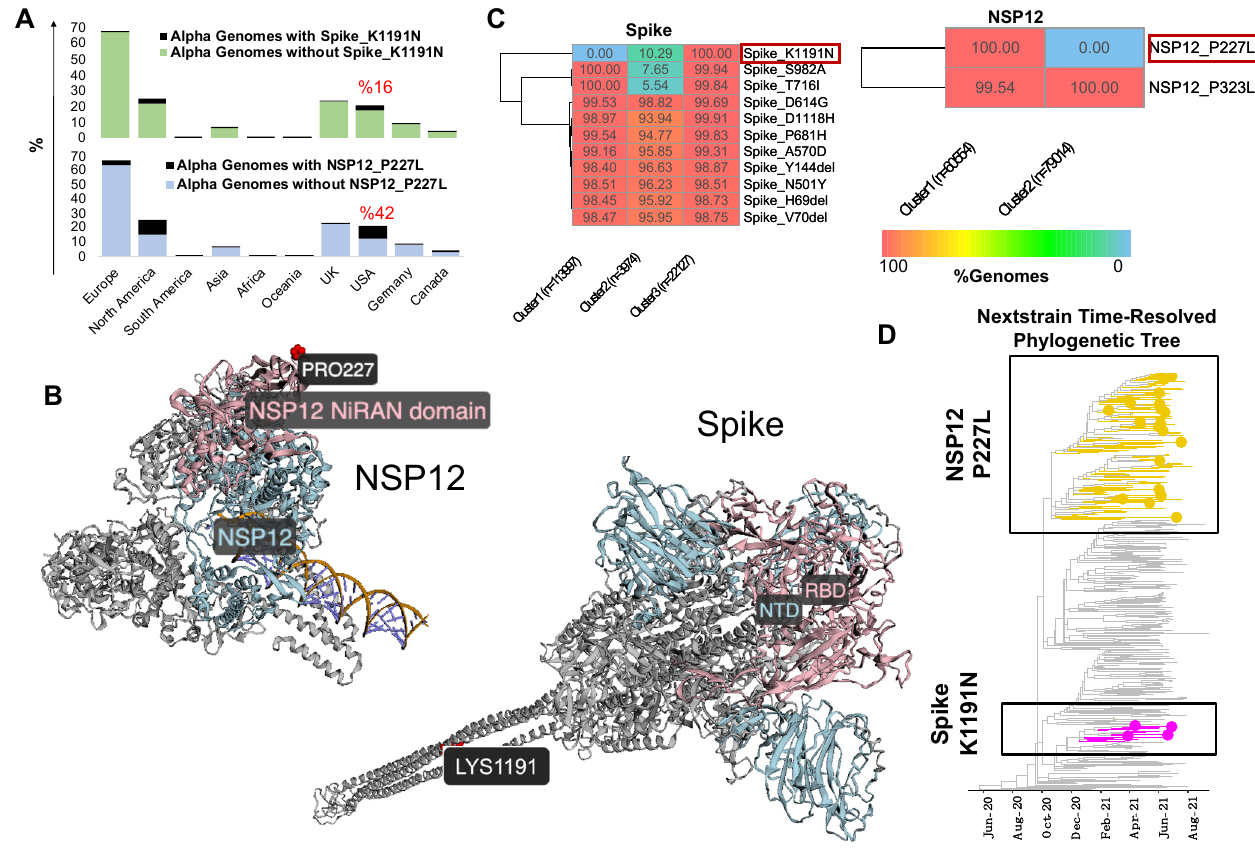
Figure 5. Analysis of Alpha VOC mutations predominantly found in USA specimens. ( A ) Relative frequency of Alpha VOC SARS-CoV-2 genomes harboring Spike K1191N ( top ) or NSP12 P227L ( bottom ) mutations. Calculations are based on GISAID data as of 31 May 2022. ( B ) Spike K1191N ( top ) or NSP12 P227L ( bottom ) mutations highlighted on available protein structures using the ViralVar “3D Protein Structure” feature. The Spike receptor-binding domain (RBD) and N-terminal domain (NTD) are colored in light blue and pink, respectively (D-I-TASSER model). NSP12 is colored in light blue with the NiRAN domain highlighted in pink (PDB: 6XEZ). ( C ) Euclidean distance-based k-means clustering of Alpha VOC SARS-CoV-2 genomes based on Spike and NSP12 mutations was performed using the “Genome Clustering” feature. Heatmaps represent the percent of genomes with a specific mutation within each cluster. Only protein mutations present in more than two thirds (70%) of genomes are shown here. ( D ) Time-resolved phylogenetic tree built by Nextstrain (https://nextstrain.org/ncov/gisaid/north-america/) accessed 14 October 2021 using a North America-focused subsampling between December 2020 and August 2021 (n = 399 sequences) visualized using R package ggtree. Yellow and hot pink branches and tips highlight genomes containing the Spike K1191N and NSP12 P227L mutations, respectively.